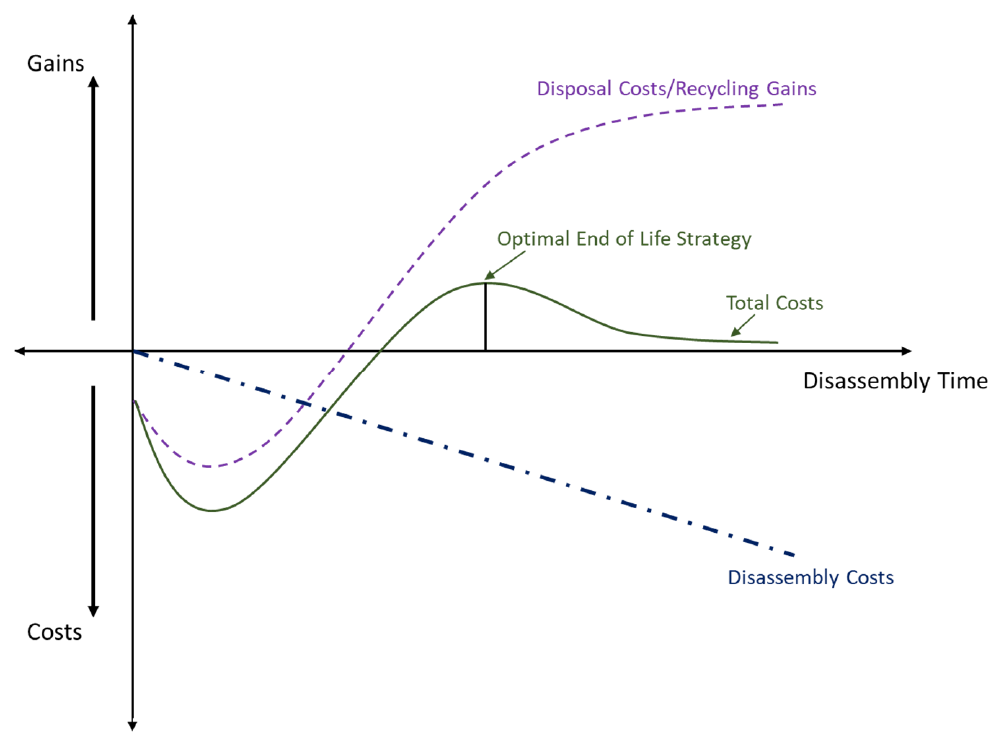
Figure 2. Cost–Benefit–Disassembly Depth Curve.